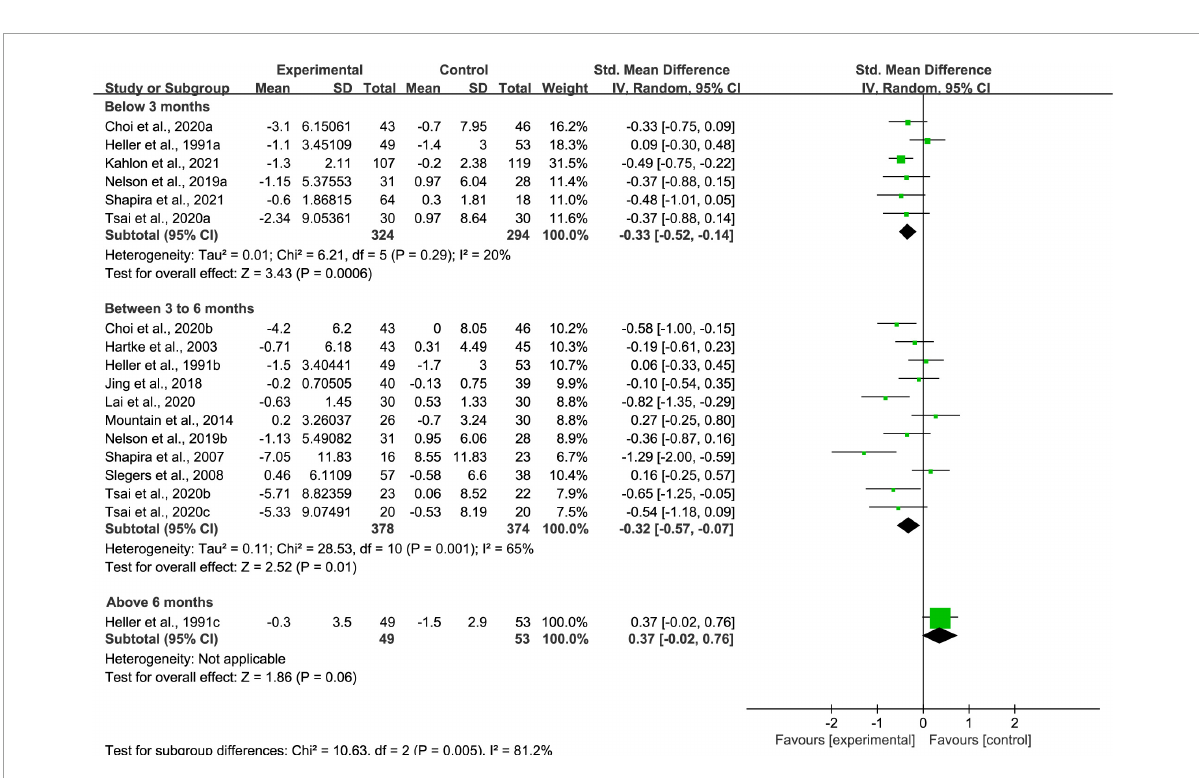
FIGURE8 Subgroup analysis: comparison of interventions at measurement time points below 3 months, between 3 and 6 months, or above 6 months and all controls on the basis of loneliness